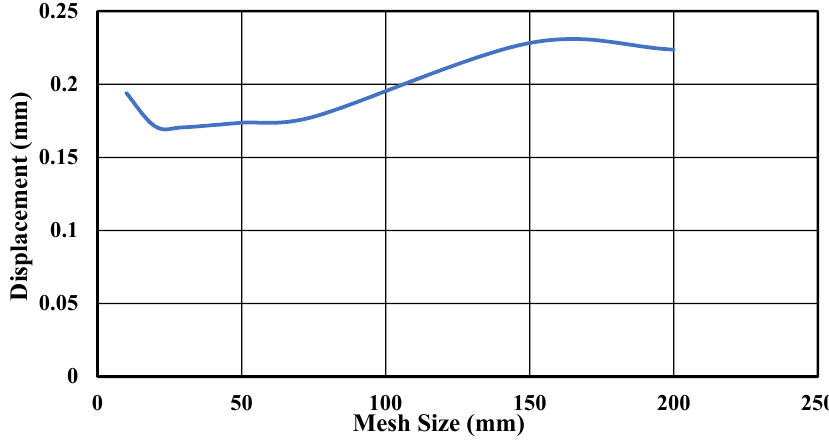
Figure 6. Results of the convergence study.